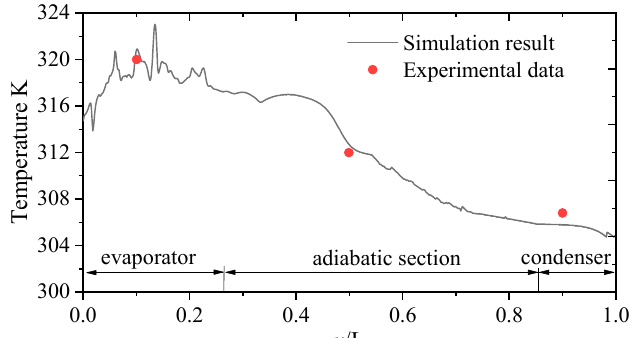
Figure 11. Startup process of RHP-GW.